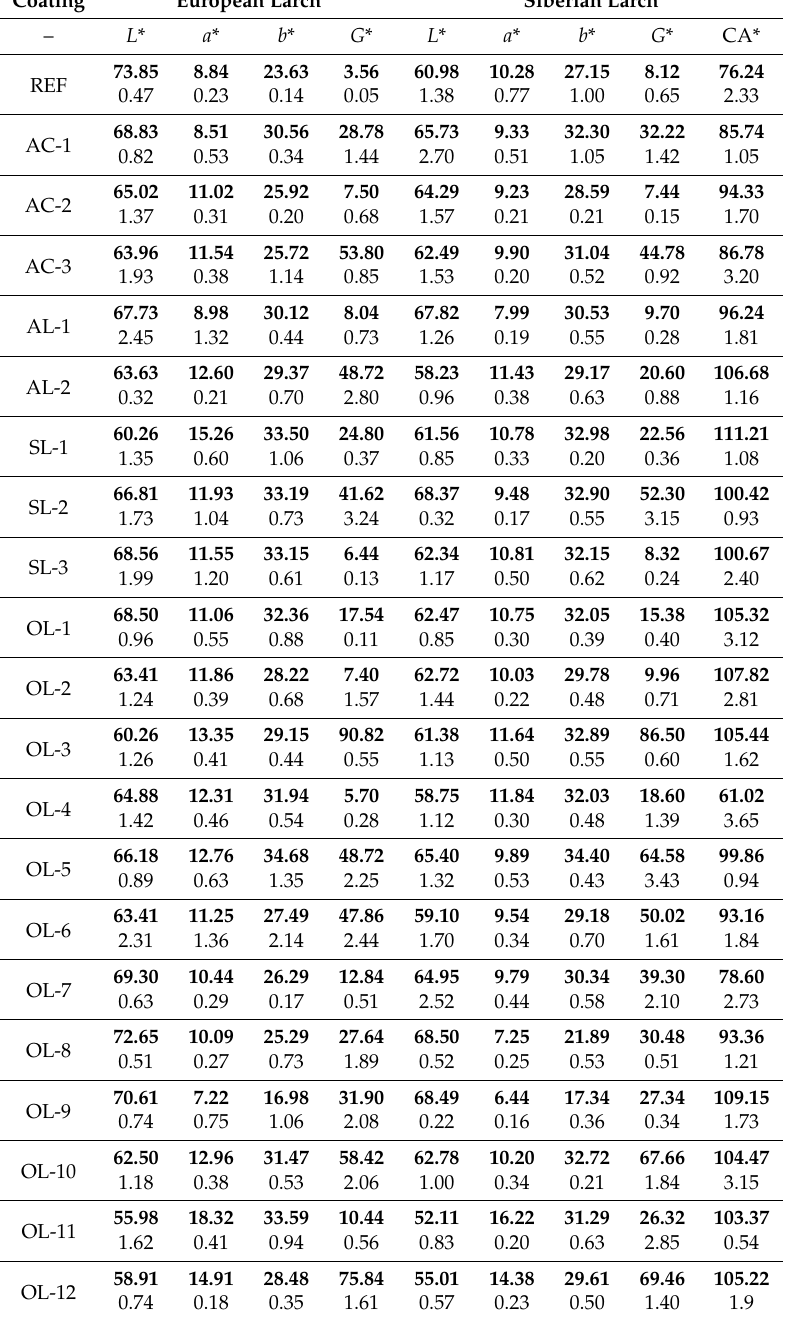
Table 2. Initial properties of tested coating systems before artificial weathering.